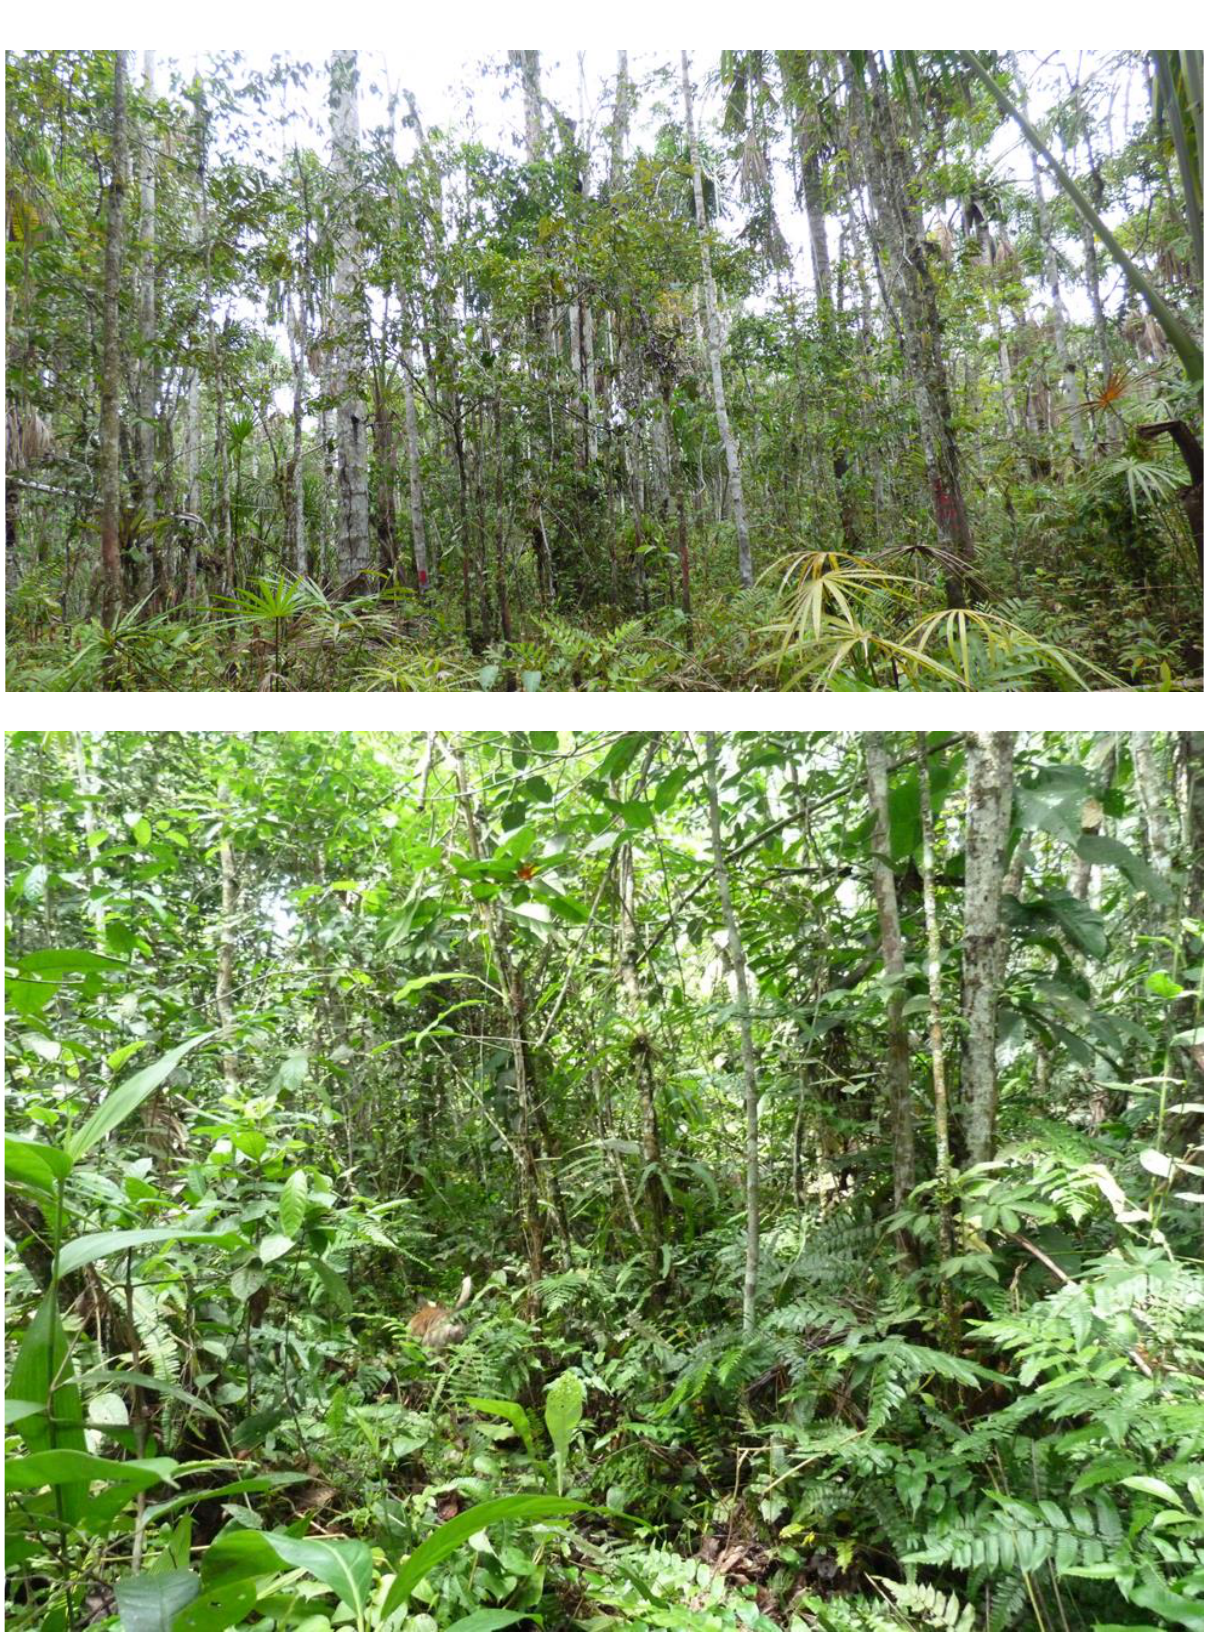
Figure 3. The two sampled swamp forests in Posic. Above: semi-dense to mixed swamp forest (SD); below: mixed swamp forest